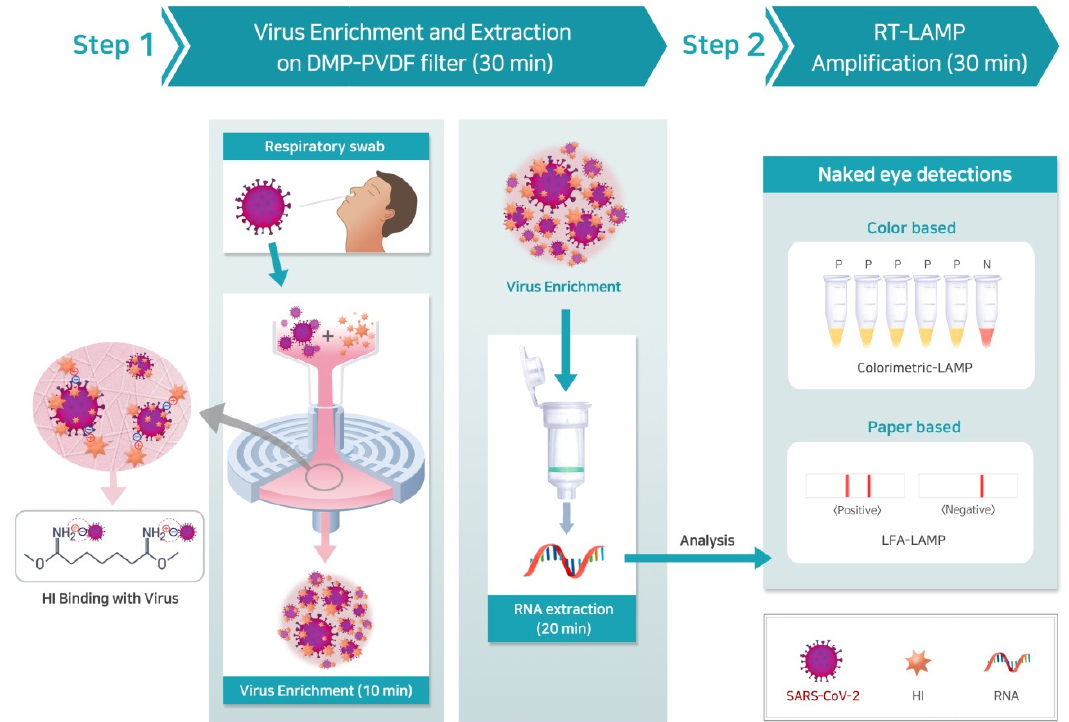
Figure 1. Schematic representation of the principle of a rapid COVID-19 diagnostic system through combining RT-LAMP and a DMP-PVDF filter platform. (Step 1) Schematic diagram of pathogen enrichment by DMP on PVDF filter. The capture of the pathogen by DMP via electrostatic interactions ( left ). The amine group of DMP enables the pathogen to be enriched on the PVDF membrane surface after 10 min of incubation ( right ). NA is extracted from the enriched pathogen. (Step 2) The extracted NA is visually confirmed by the naked-eye to pathogen detection via colorimetric RT-LAMP (top path) and RT-LAMP with LFA (bottom path). RT, reverse transcription; LAMP, loop-mediated isothermal amplification; DMP, dimethyl pimelimidate; PVDF, polyvinylidene fluoride; NA, Nucleic acid; LFA, lateral flow assay.